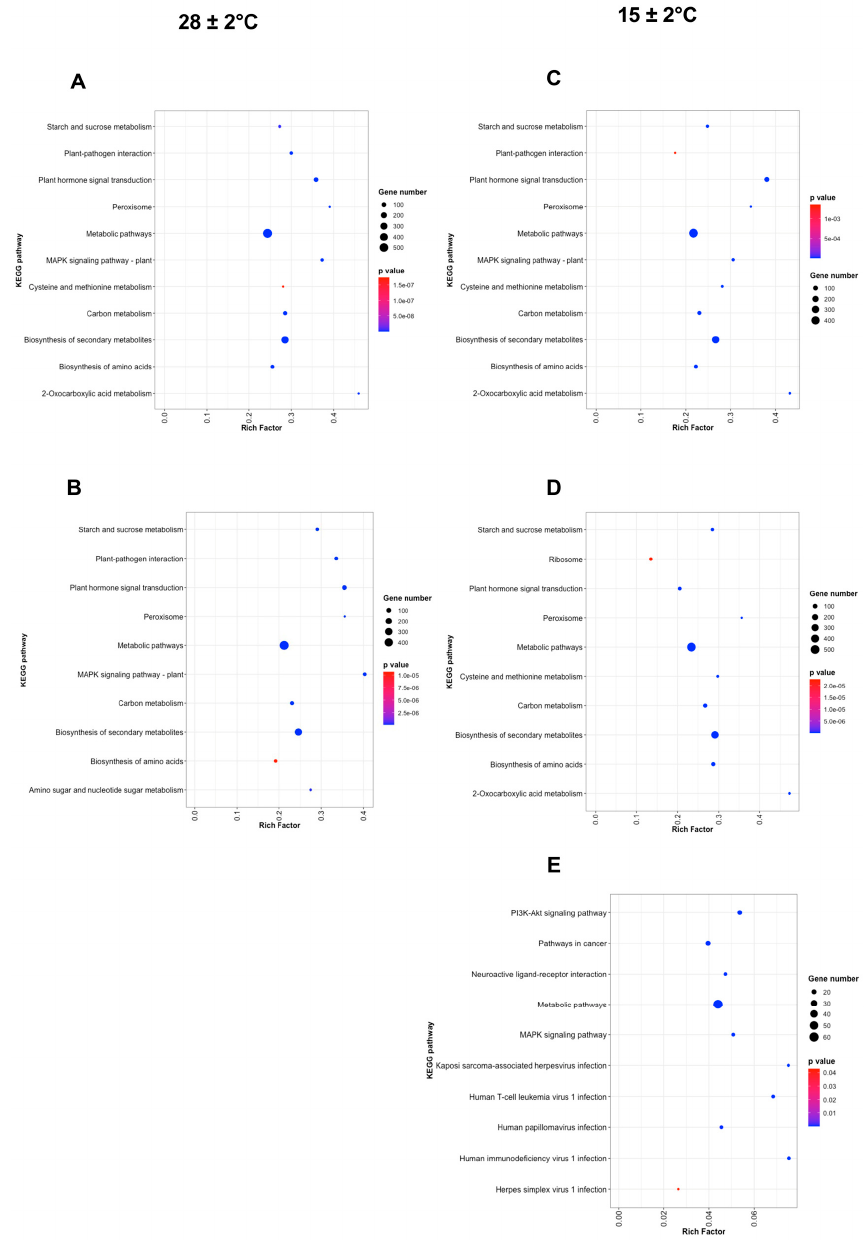
Figure 7. Top 10 significantly enriched KEGG pathways of the DEG by each pairwise comparison against Day 0, ( A ) Day 3 at 28 ± 2 ◦ C, ( B ) Day 6 at 28 ± 2 ◦ C, ( C ) Day 3 at 15 ± 2 ◦ C, ( D ) Day 6 at 15 ± 2 ◦ C, ( E ) Day 9 at 15 ± 2 ◦ C. The y -axis represents the KEGG enriched pathways and the x -axis represents the Rich Factor. The circle size indicates the number of genes in each KEGG pathway. Colors correspond to the adjusted p